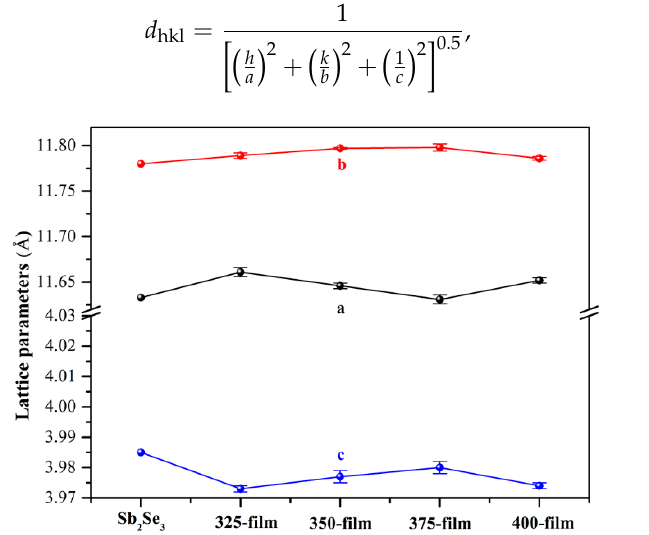
Figure 3. The lattice parameters of Te-Sb 2 Se 3 thin films at different annealing temperatures and pure Sb 2 Se 3 .